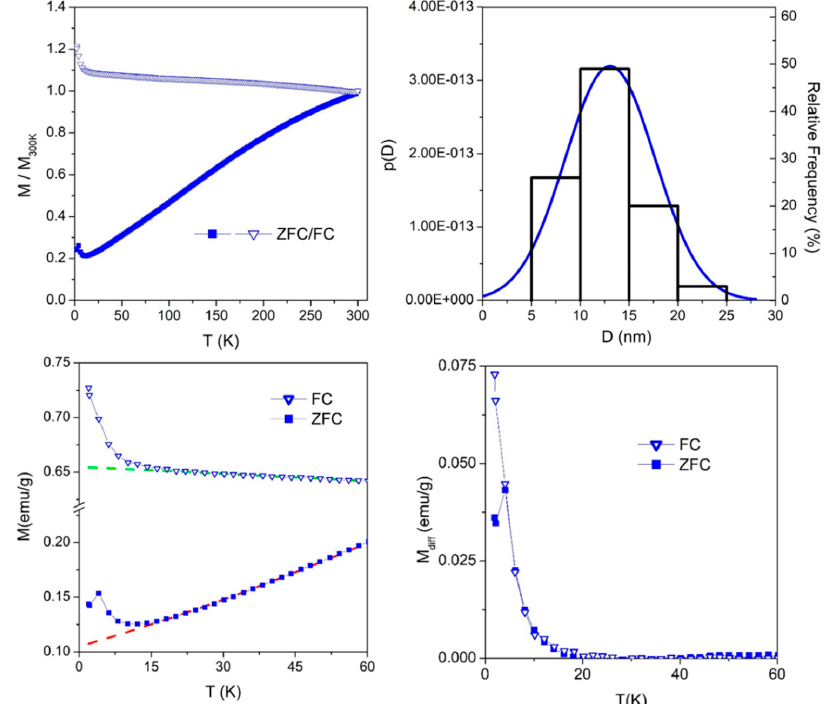
Figure 15. Hysteresis loops measured in sample NiX735C—12 min in the temperature interval 2–300 K and in the field range − 70 kOe ≤ H ≤ 70 kOe. Upper inset: high-field magnetization as a function of temperature; lower inset: detail of the low-field region for three temperatures.